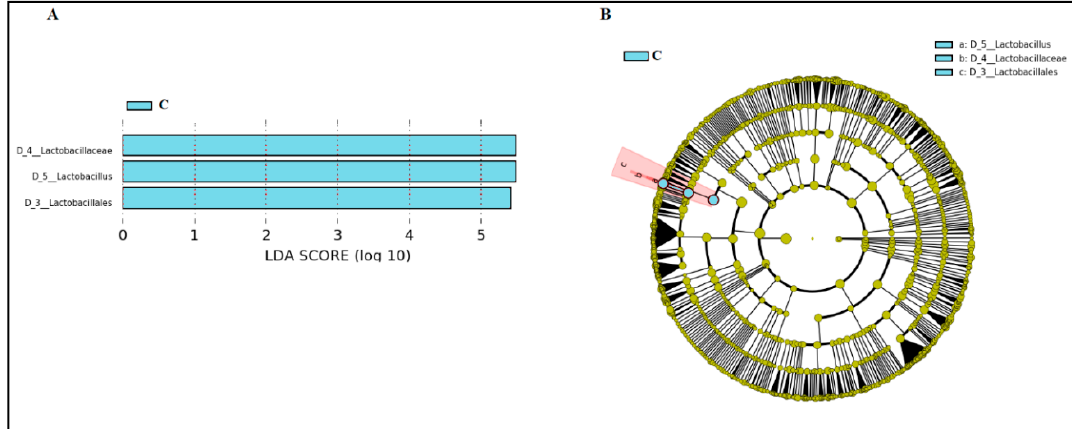
Figure 4. LEfSe analysis identifying taxonomic differences in the microbiota of CVL samples from healthy fertile women (C, bluish green) and women with repetitive abortion (RA) and with infertility of unknown origin (INF). Differentially abundant bacterial taxa were identified using linear discriminant analysis (LDA) and the effect size (LEfSe) algorithm. ( A ) Histogram of LDA scores (absolute LDA (log 10 ) score > 2.0, p < 0.05) showing the substantial enrichment of Lactobacillus in the microbiota profile of the CVL samples from healthy fertile women. ( B ) Cladogram showing LEfSe comparison of differential bacterial taxa in CVL samples. The central point represents the root of the bacterial tree and each ring the next lower taxonomic level from phylum to genus (from the inner to the outer ring: phylum, class, order, family, and genus). The color node (other than yellow) indicates which taxa are significantly higher in relative abundance, and the diameter of the node is proportional to the relative abundance of the taxon.